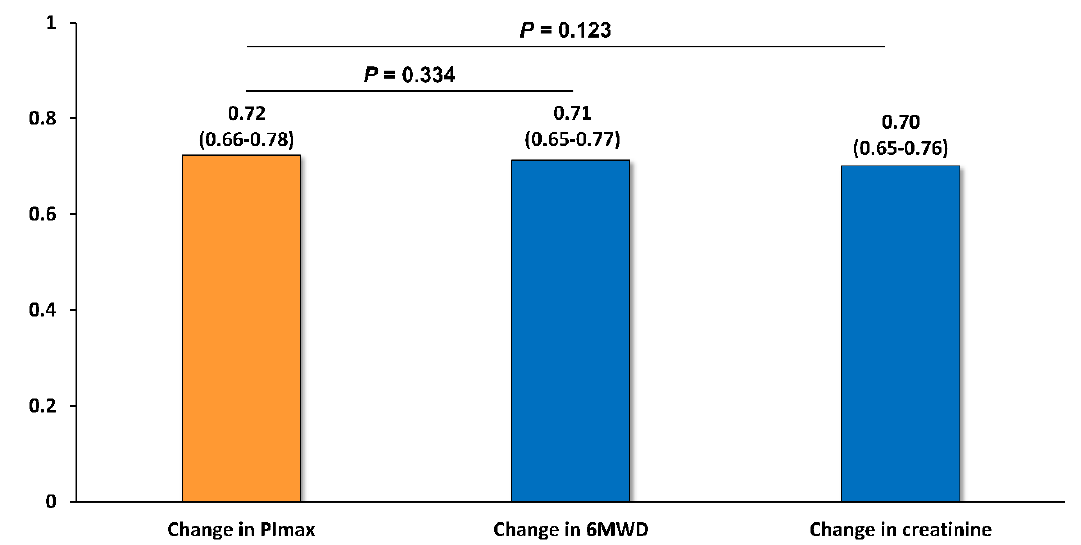
Figure 5. C-index of adjusted models of changes in PI max , 6MWD, and creatinine for all-cause clinical events. Data, C-index (95% CI). Models were adjusted for variables used in multivariate Poisson regression analyses. PI max , maximal inspiratory pressure; 6MWD, 6-min walk distance.